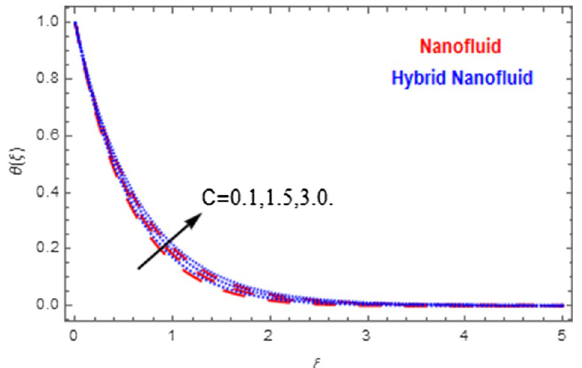
Figure 15. Variation in temperature field of nanofluid ( Al 2 O 3 ) and hybrid nanofluid ( Al 2 O 3 , CuAl 2 O 3 , Cu ) against different estimations of C .